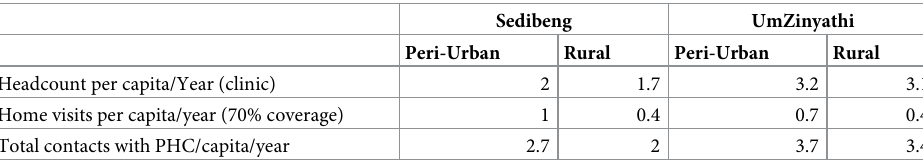
Table 7. Health care utilization in Sedibeng and